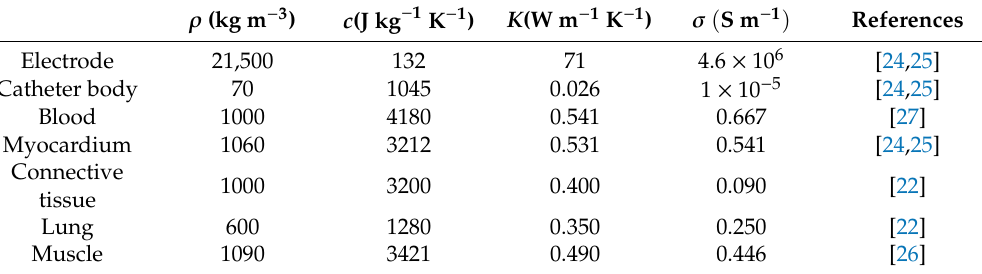
Table 1. Thermal and electrical properties of human and porcine tissue.